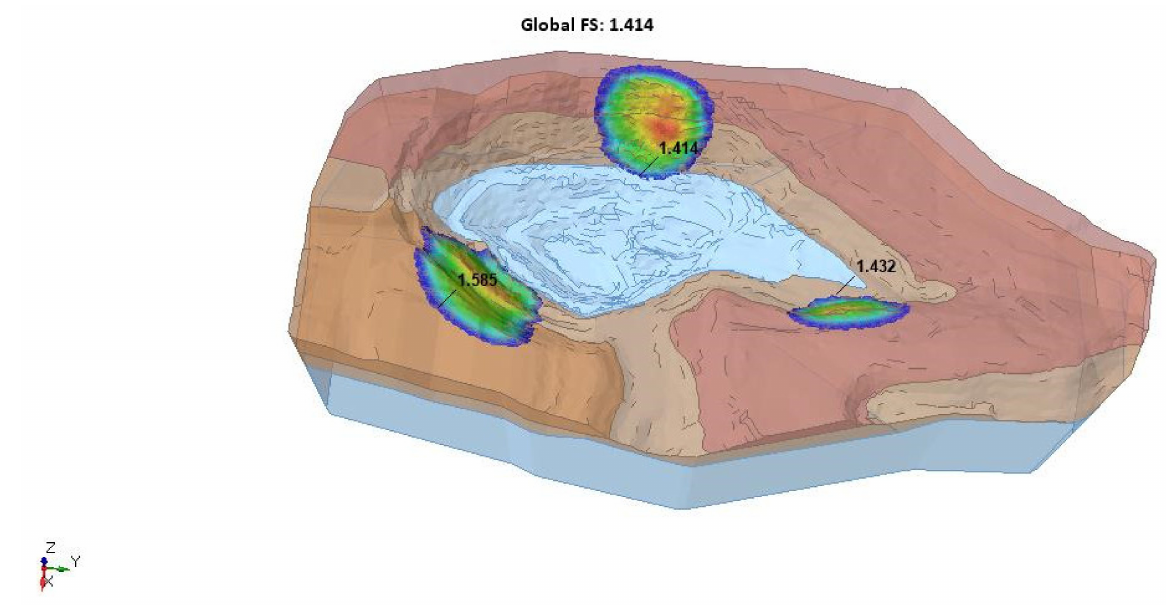
Figure 14. Contours of multi-material slip surfaces (deterministic analysis).